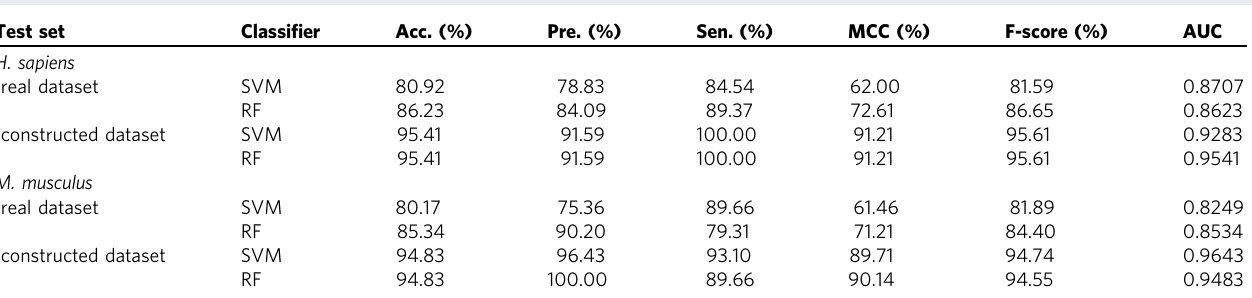
Table 1 Prediction results by using two classi fi ers on H. sapiens and M. musculus datasets. Test